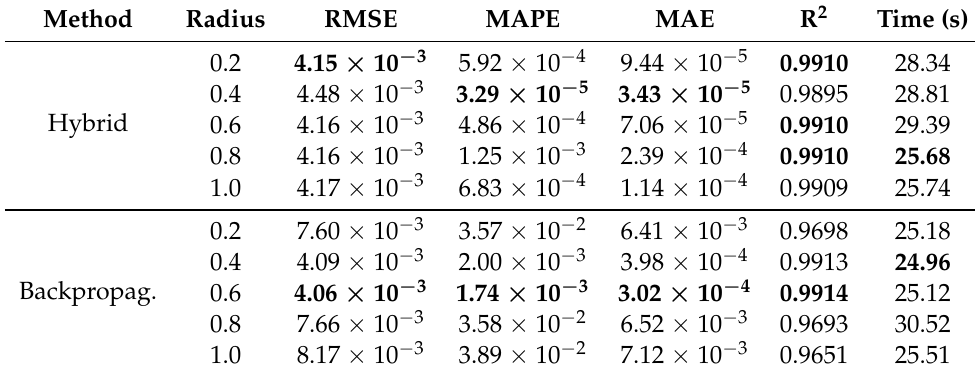
Table 4. Evaluation of ANFIS subtractive clustering hyperparameters.